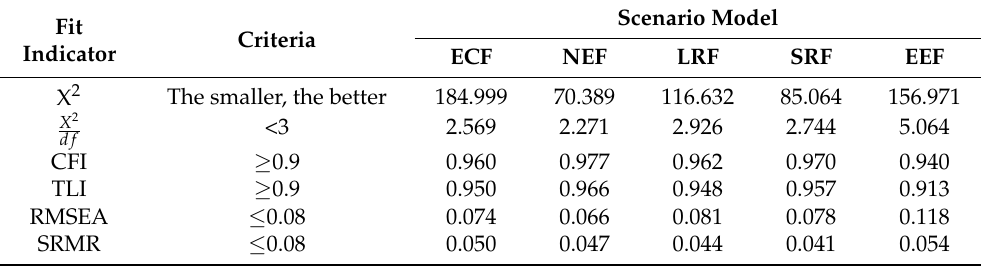
Table 3. Test of fitting degree of SEM.